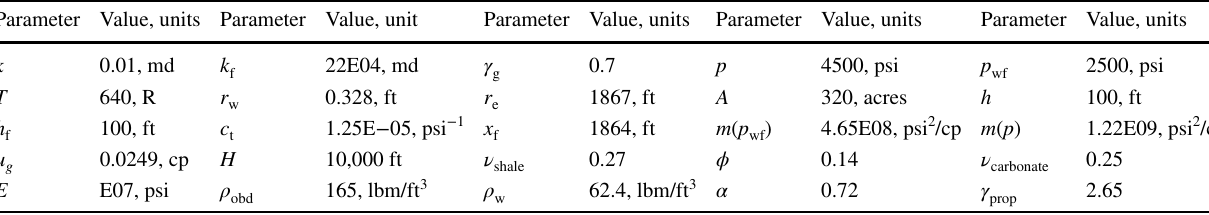
Table 1 Stimulation data Parameter Value, units Parameter Value,